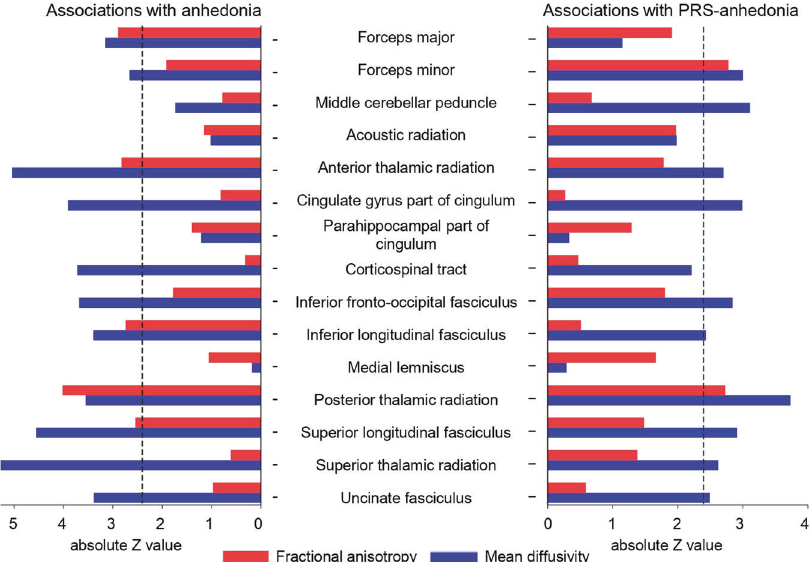
Fig. 2 Associations between anhedonia (left panel) and polygenic risk for anhedonia (right panel) and white matter integrity. The y -axis represents the white matter tracts tested in our analyses. The x -axis represents the absolute Z values for anhedonia and polygenic risk for anhedonia in regression models. Fractional anisotropy and mean diffusivity are separately shown in red and blue. The absolute Z = 2.4 black dashed lines indicates signi fi cance. This value was chosen according to the signi fi cance of each regression model. In the left panel, bars to the left of the black dashed line indicate signi fi cant associations between anhedonia and corresponding white matter tracts. In the right panel, bars to the right of the black dashed line are signi fi cant, indicating associations between polygenic risk for anhedonia and white matter